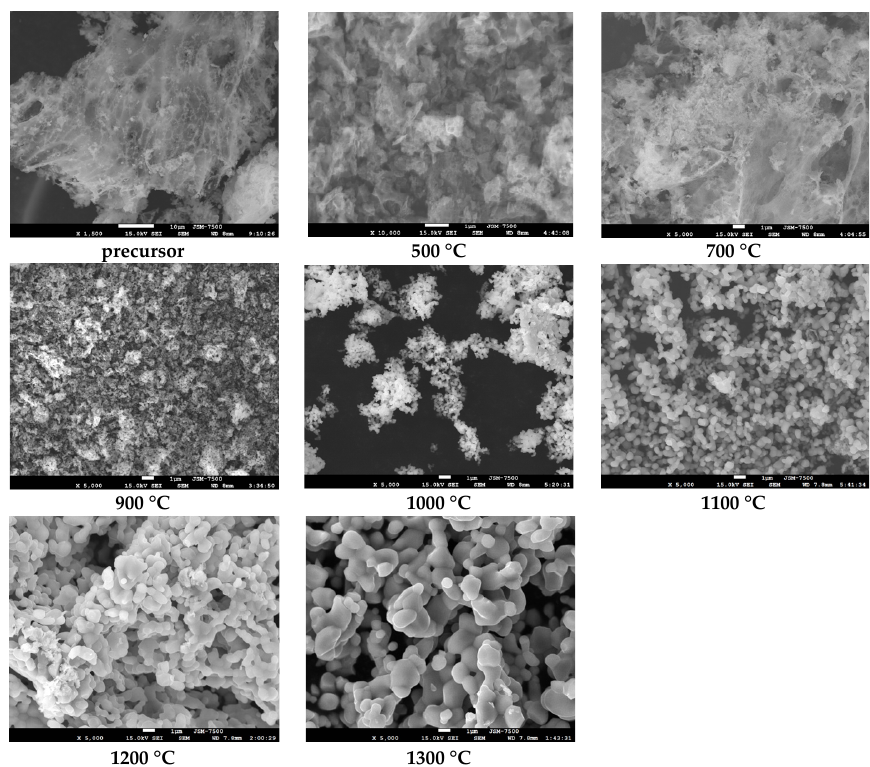
Figure 2. SEM images of the MgFe 2 O 4 powders calcined at the various temperatures.